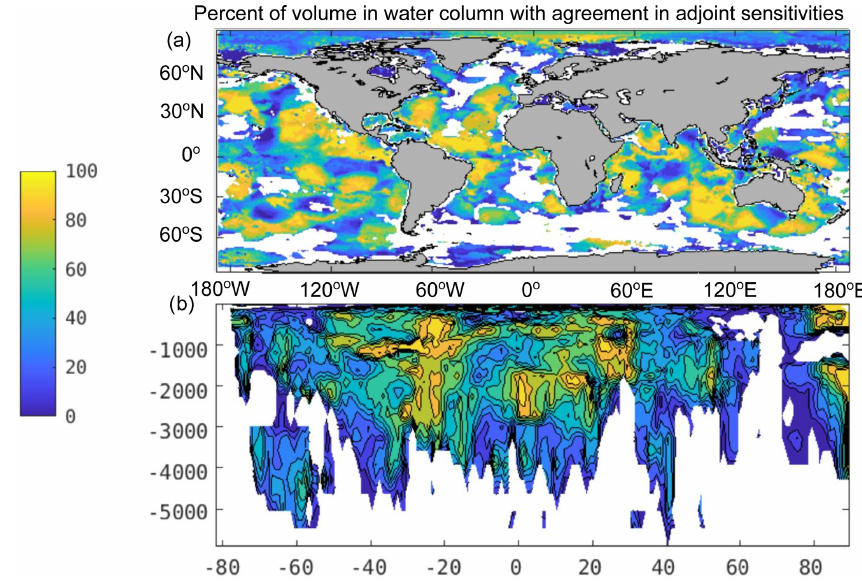
Figure 11. Adjoint sensitivity sign comparisons: same as Fig. 10, except using the de Lavergne et al. (2020) product, κ ρ, tides